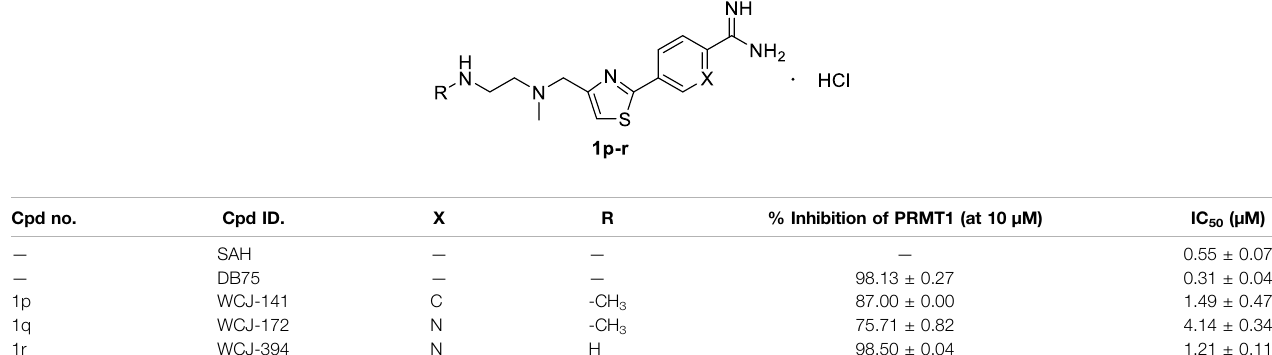
TABLE 3 | Inhibitory activities of 2,4-substituted thiazole derivatives 1p – r against PRMT1.